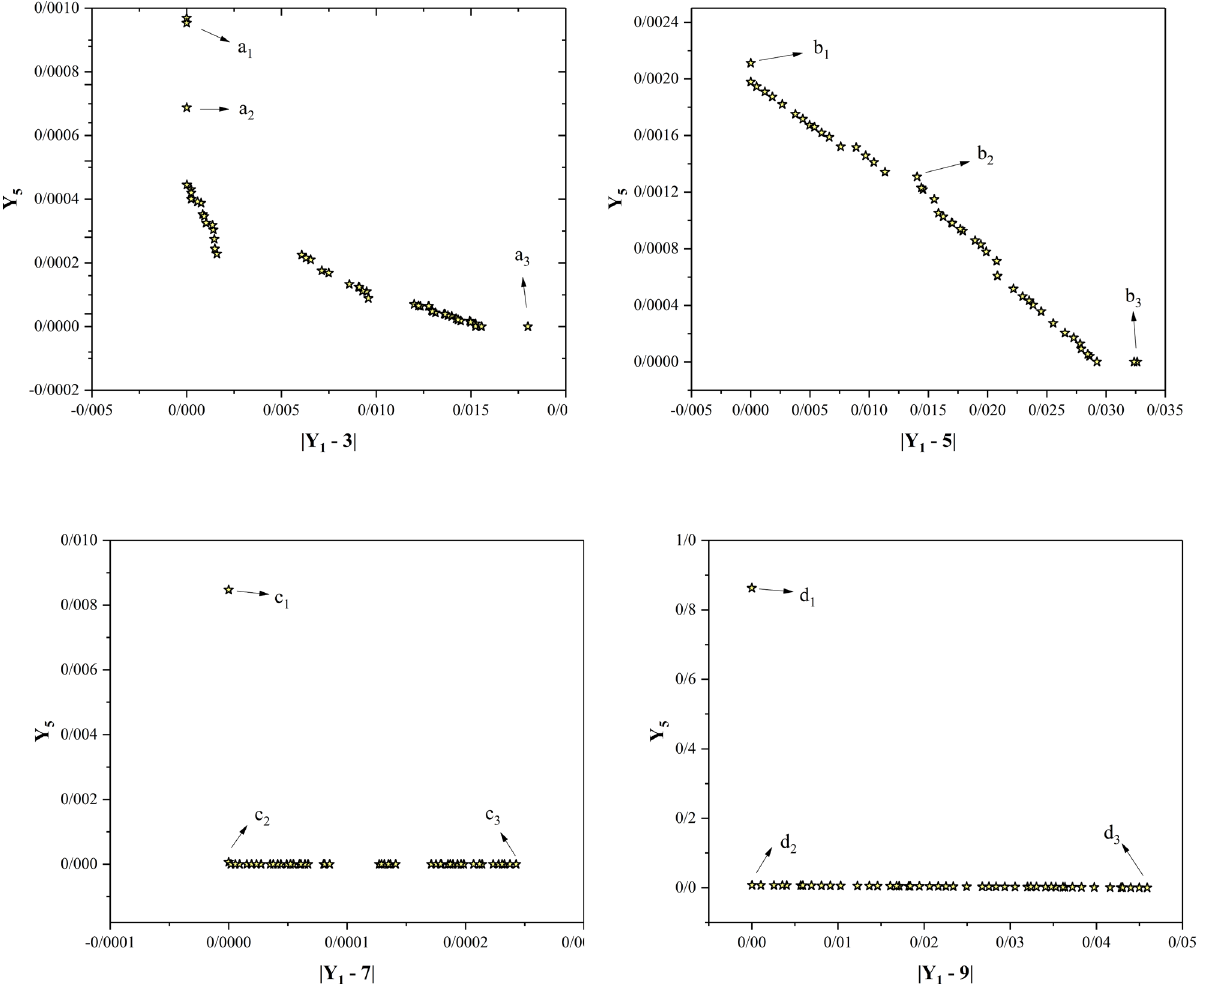
Figure 12: Pareto optimal front for minimizing b* (Y5) and obtaining different amounts (3, 5, 7, and 9 μm) of PS (Y1) (specified points are introduced in supporting